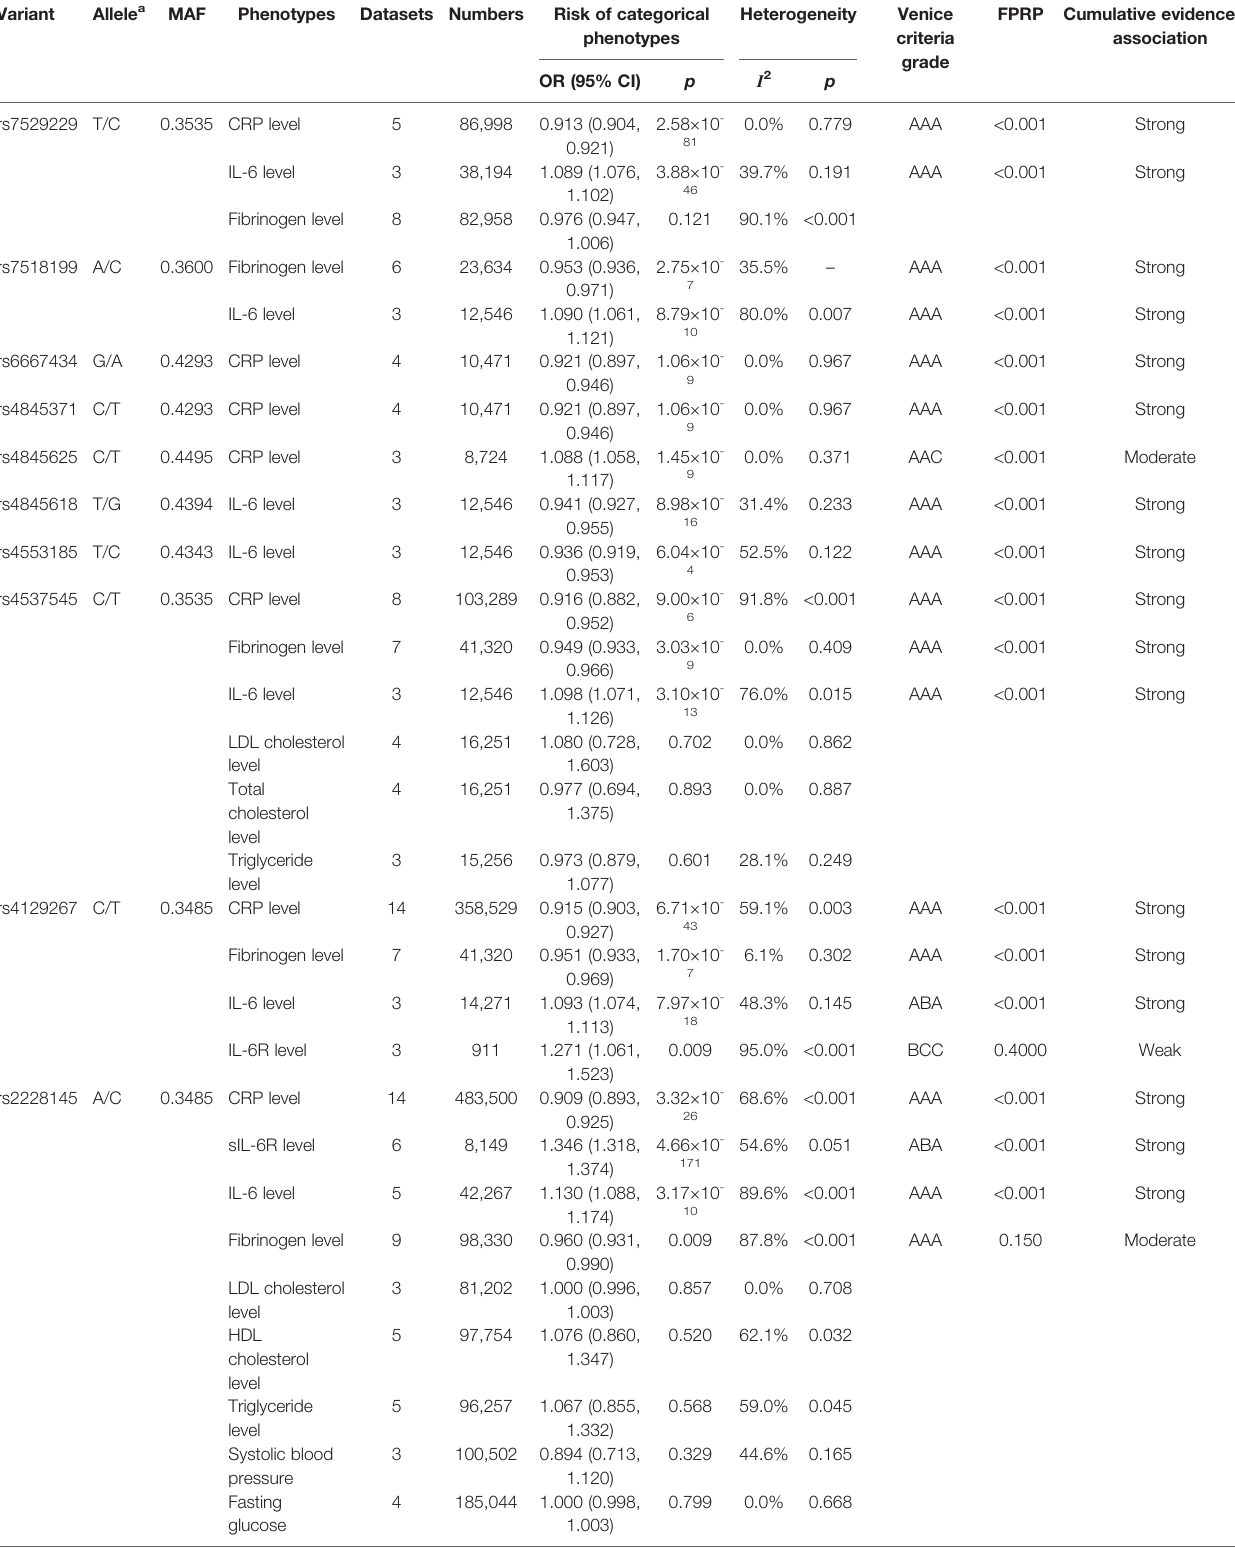
TABLE 2 | Variants in the IL6R gene associated with relevant categorical phenotypes in meta-analysis.